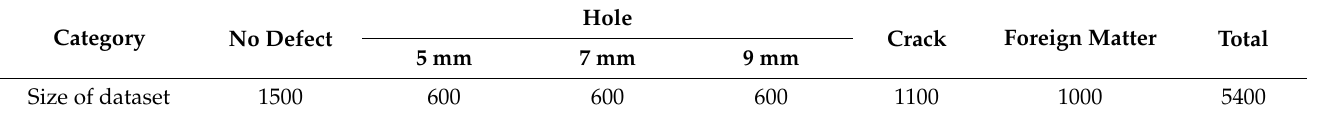
Figure 9. Ultrasonic detection hardware system. Table 1. The size and category of datasets.